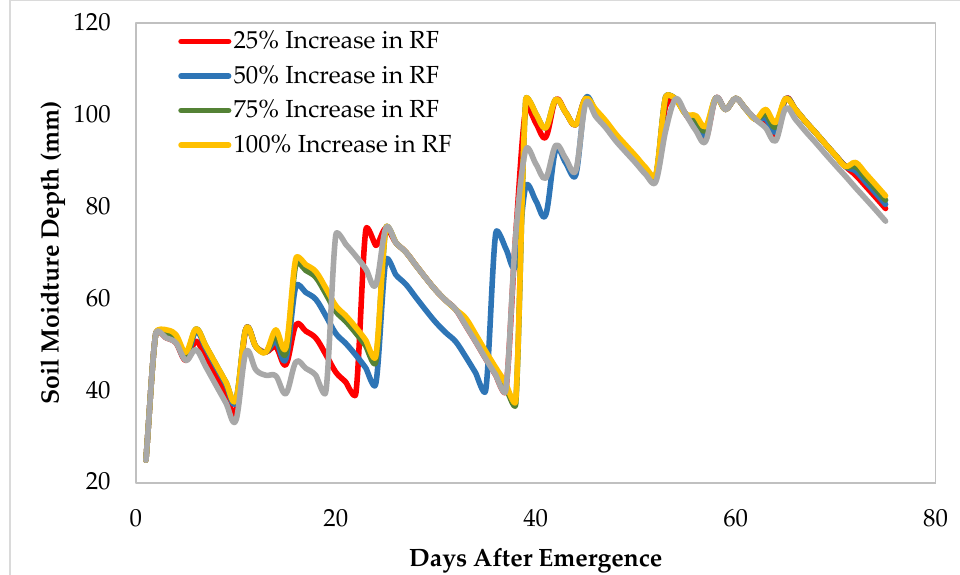
Figure 9. Model simulations under increased rainfall scenarios.